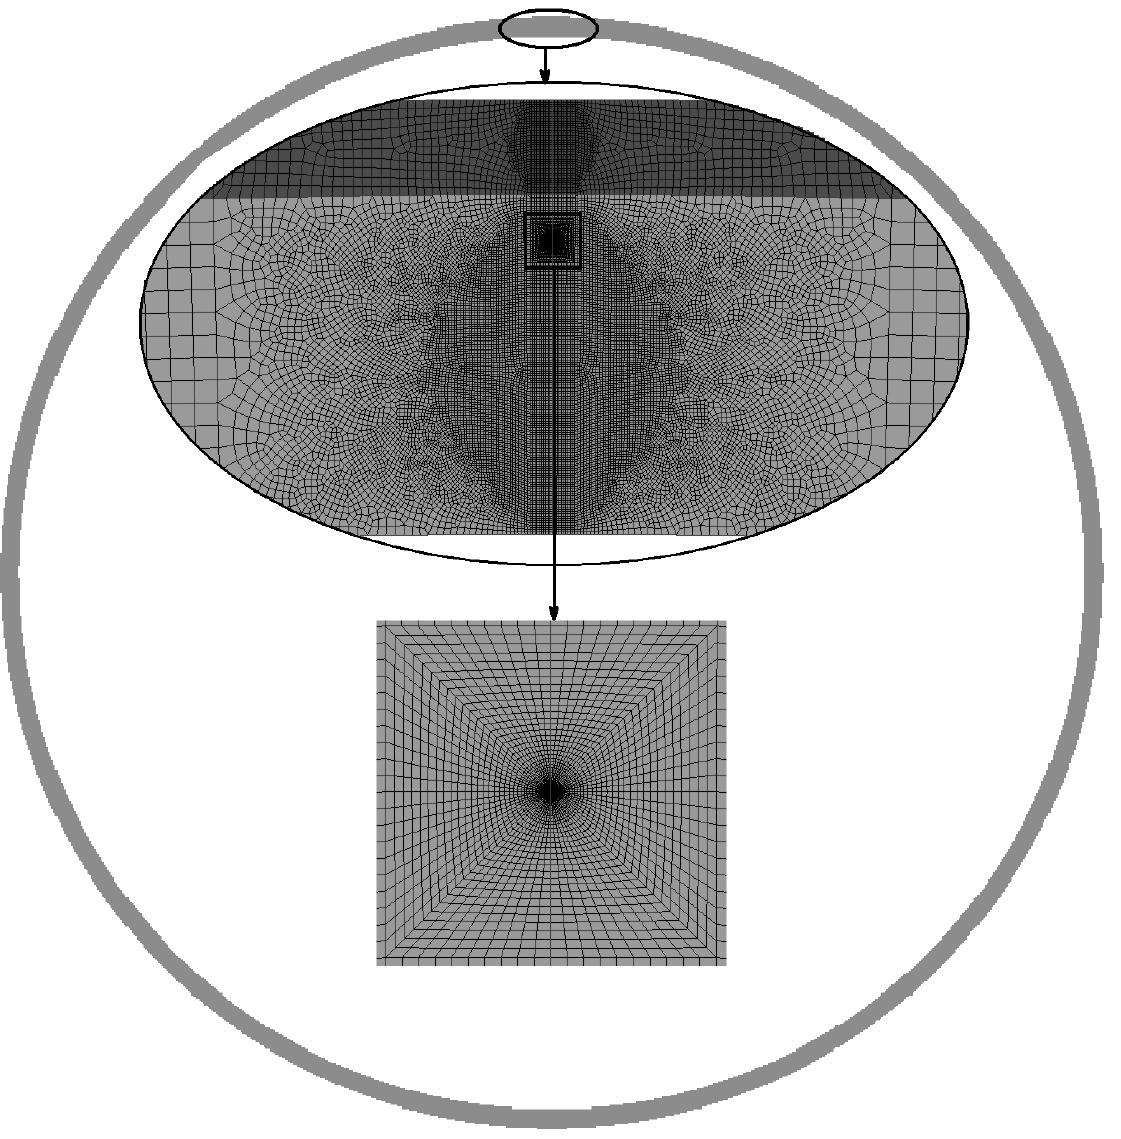
Figure 3. Schemes of finite element splitting of a crack’s surroundings.